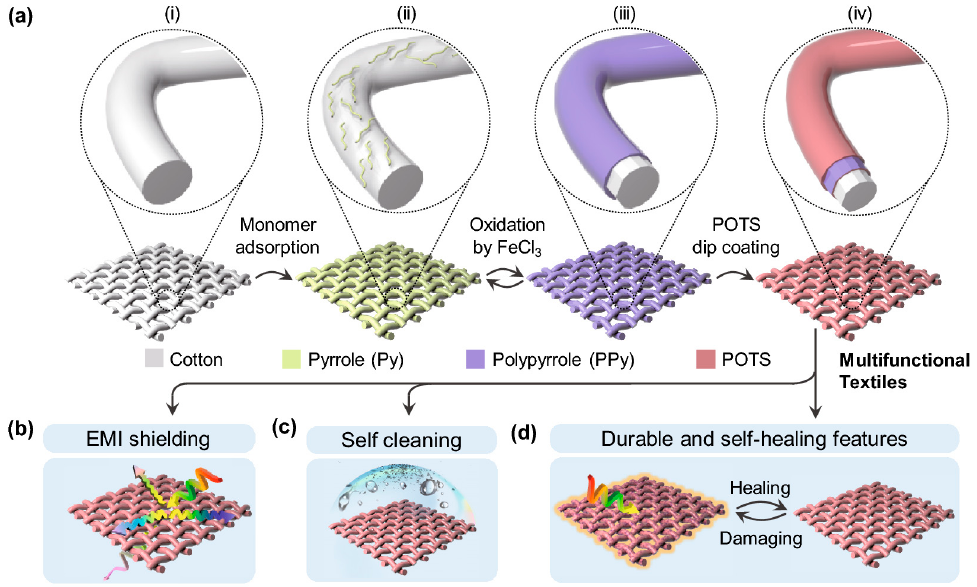
Figure 8. Preparation of PPy n @POTS fabrics. ( a ) Fabrication process of PPy n @POTS fabrics via a dip-coating approach. The desired number of PPy coating layers can be obtained by repeating the adsorption-oxidation process before the final protection layer coating of POTS. ( b – d ) Resulting multifunctionality of the coated fabric with high EMI shielding (PPy), self-cleaning (POTS), and durable performance assisted by near-instantaneously self-healing capability. From [136], copyright (2021), the authors. (i–iv) denote subsequent steps of the fabrication process.